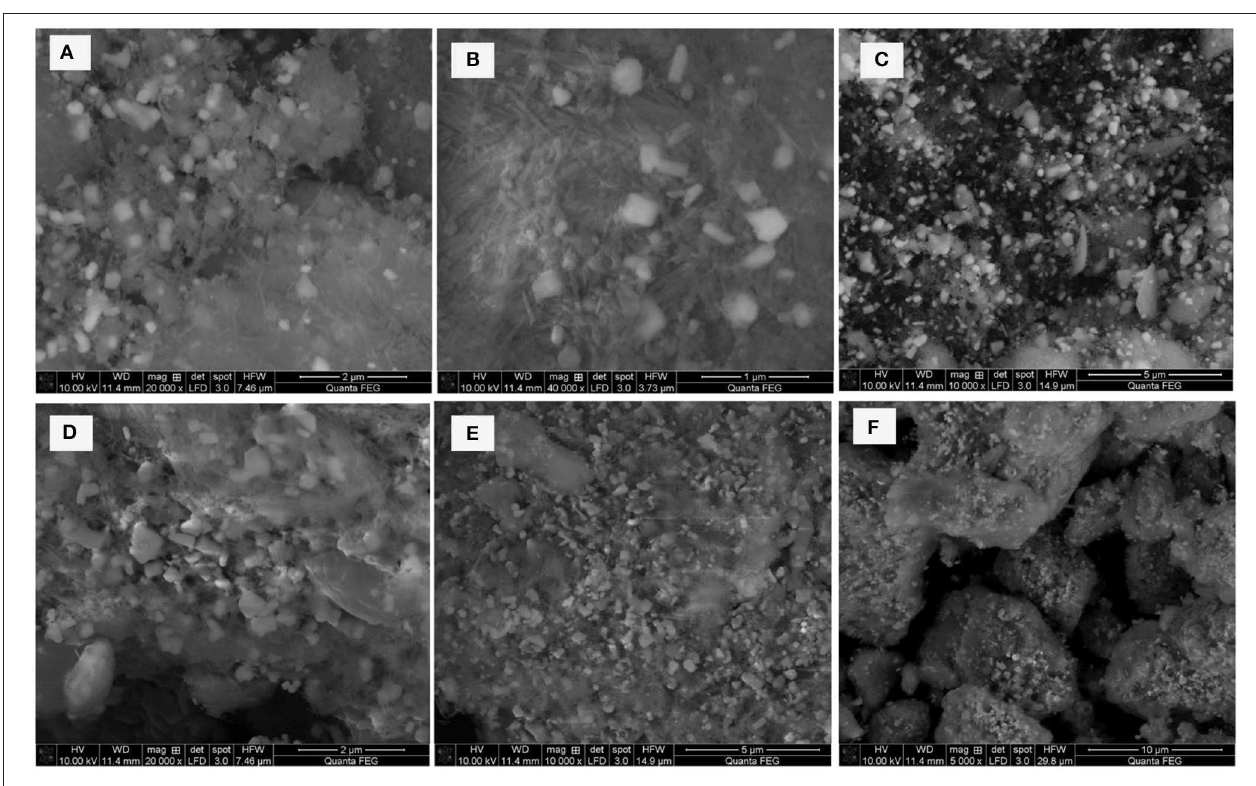
FIGURE 6 | SEM images of (A,B,C) PTSp/ZnO, (D,E,F) S/PTSp/ZnO.